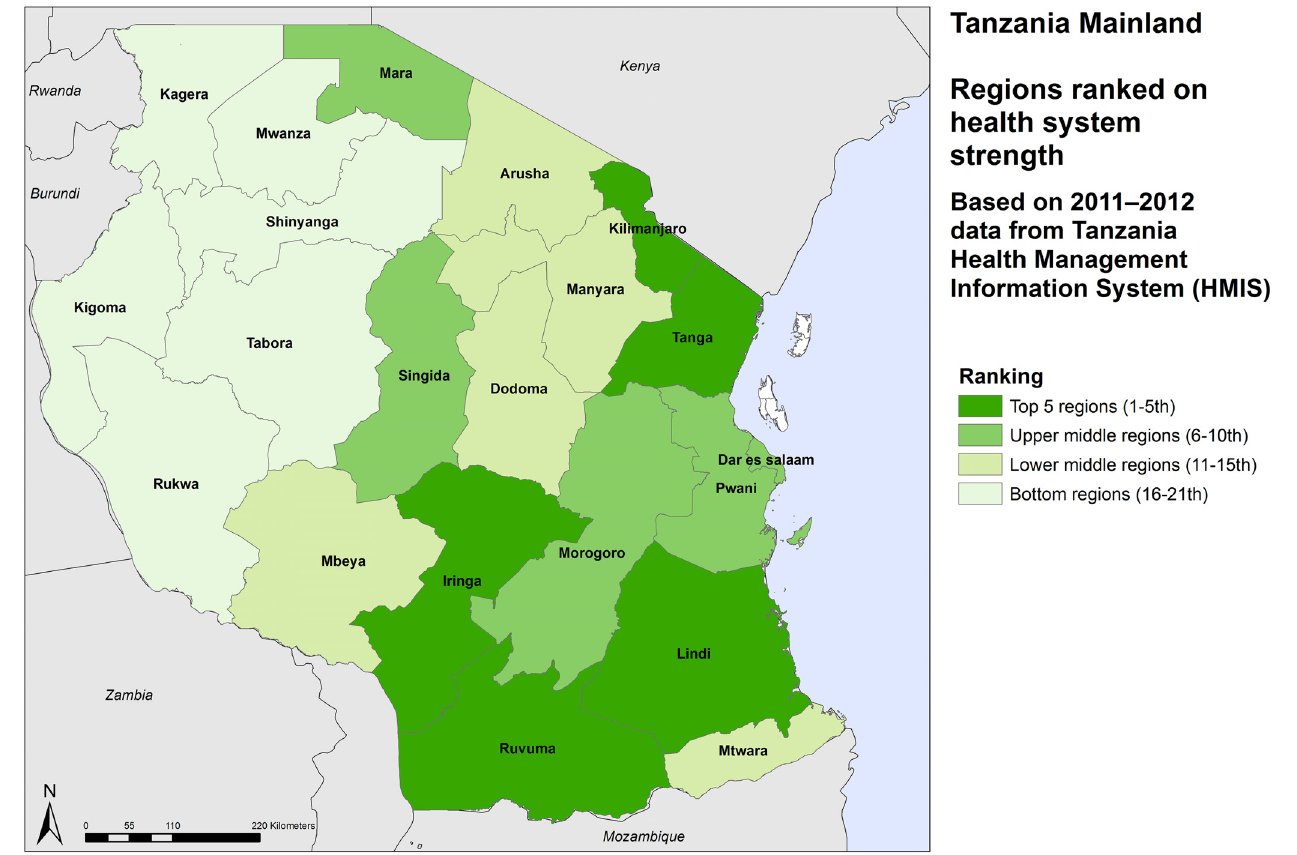
Fig 1. Relative ranking of regions on the health system strength, Tanzania mainland,